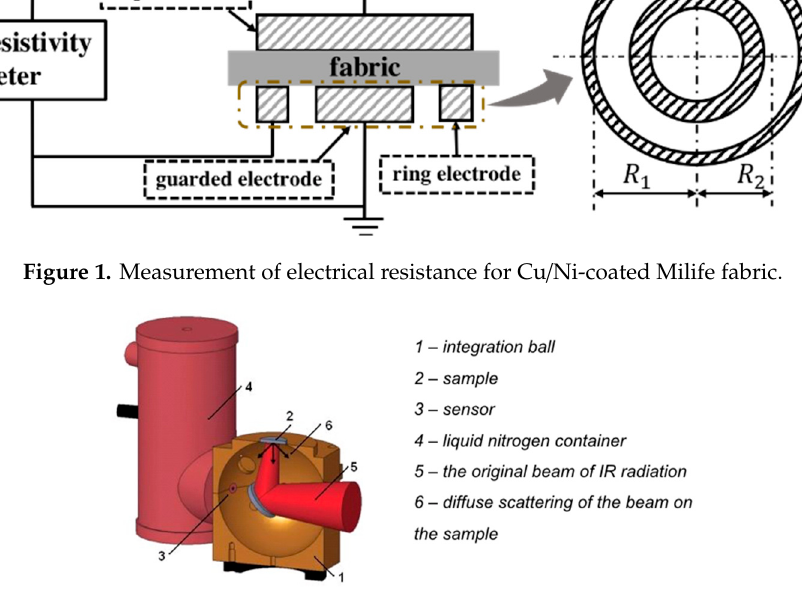
Figure 3. Measurement of thermal insulation for Cu/Ni-coated Milife fabric.